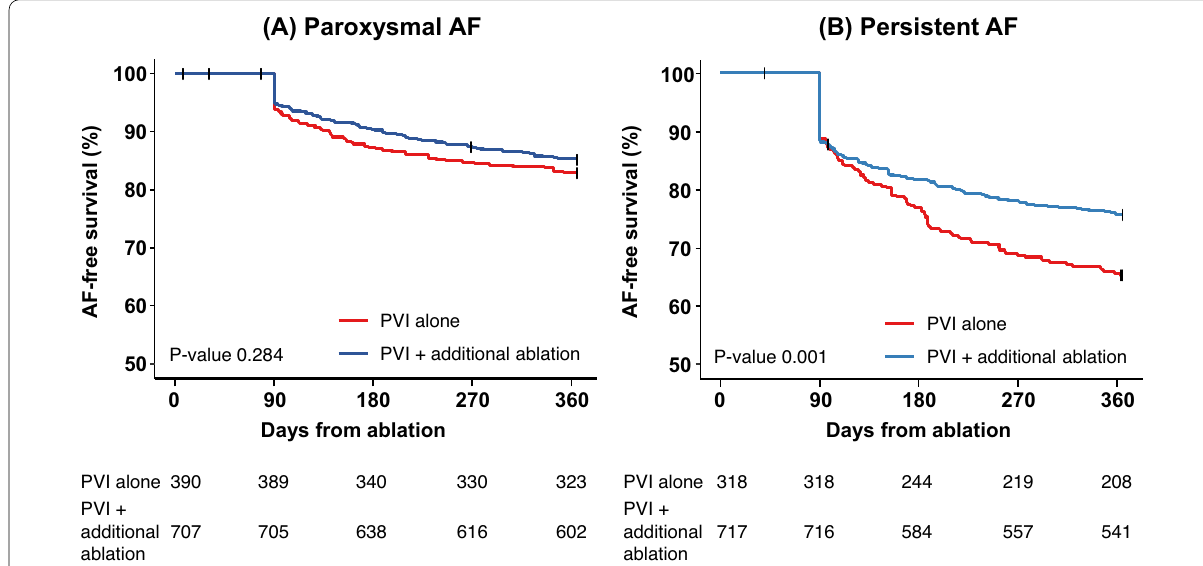
Fig. 4 Kaplan–Meier survival curve for recurrence of atrial tachyarrhythmia according to the ablation strategies. Pulmonary vein isolation plus additional ablation did not influence the recurrence of AF in the patients with paroxysmal AF ( A ). However, it affected lower AF recurrence rate in the patients with persistent AF ( B ). AF, atrial fibrillation; PVI, pulmonary vein